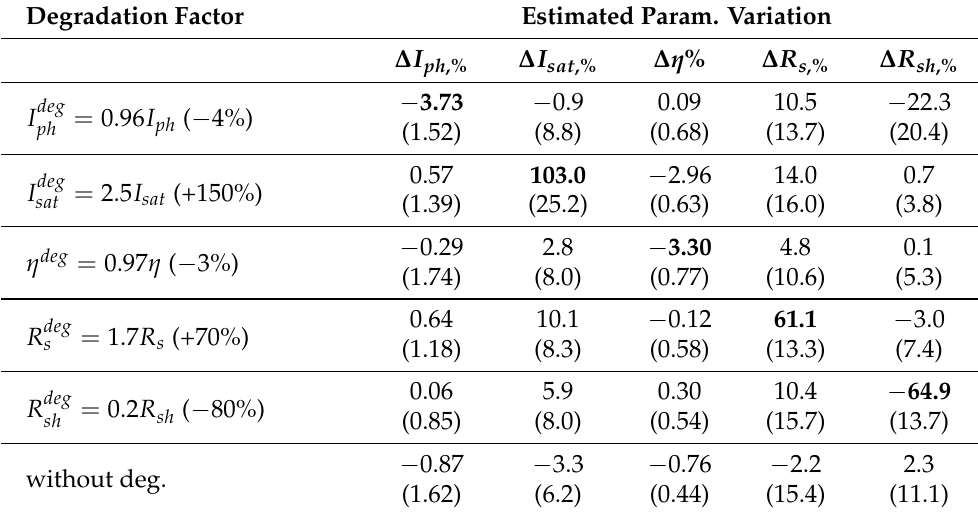
Table 10. Average of SDM parameters variation (in %) estimated with ANN. Degradation